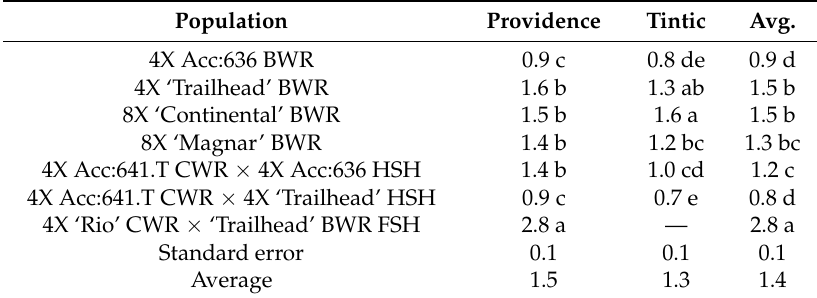
Table 2. Dry matter yield (Mg · ha − 1 ) for tetraploid (4X) and octoploid (8X) populations of basin